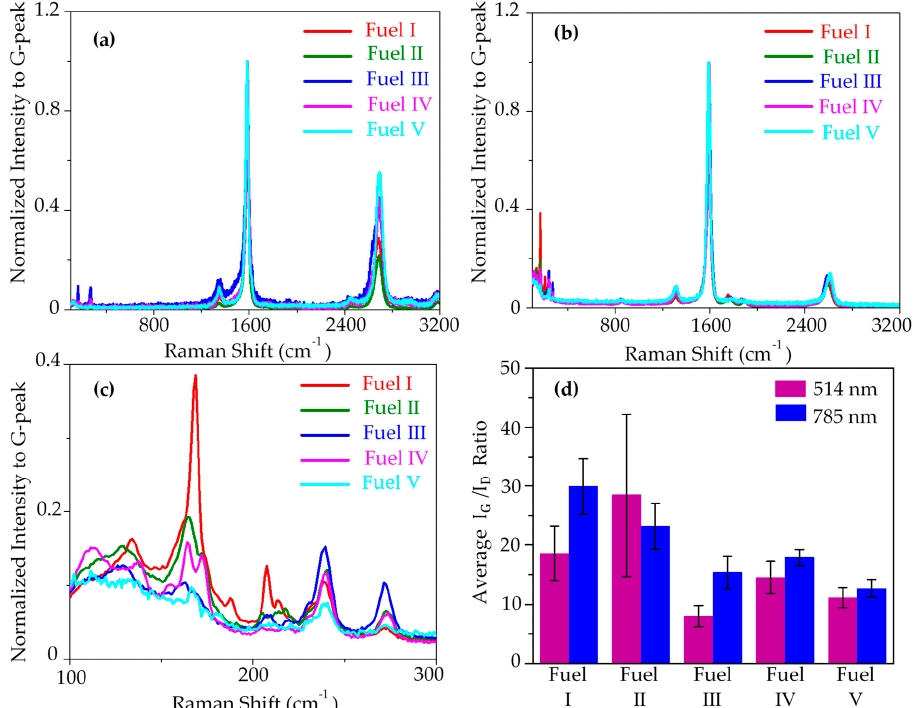
Figure 12. Raman spectroscopy plot for samples synthesized from the five fuels I–V: ( a ) 514 nm laser spectra normalized to G-peak. ( b ) 785 nm laser spectra normalized to G-peak. ( c ) RBM peaks from 785 nm laser. ( d ) Average I G /I D of the samples from 514 nm and 785 nm. The instability of nickelocene at high temperatures has an effect on the process of carbon dissolution into the metal-liquid phase and subsequent precipitation of carbon into